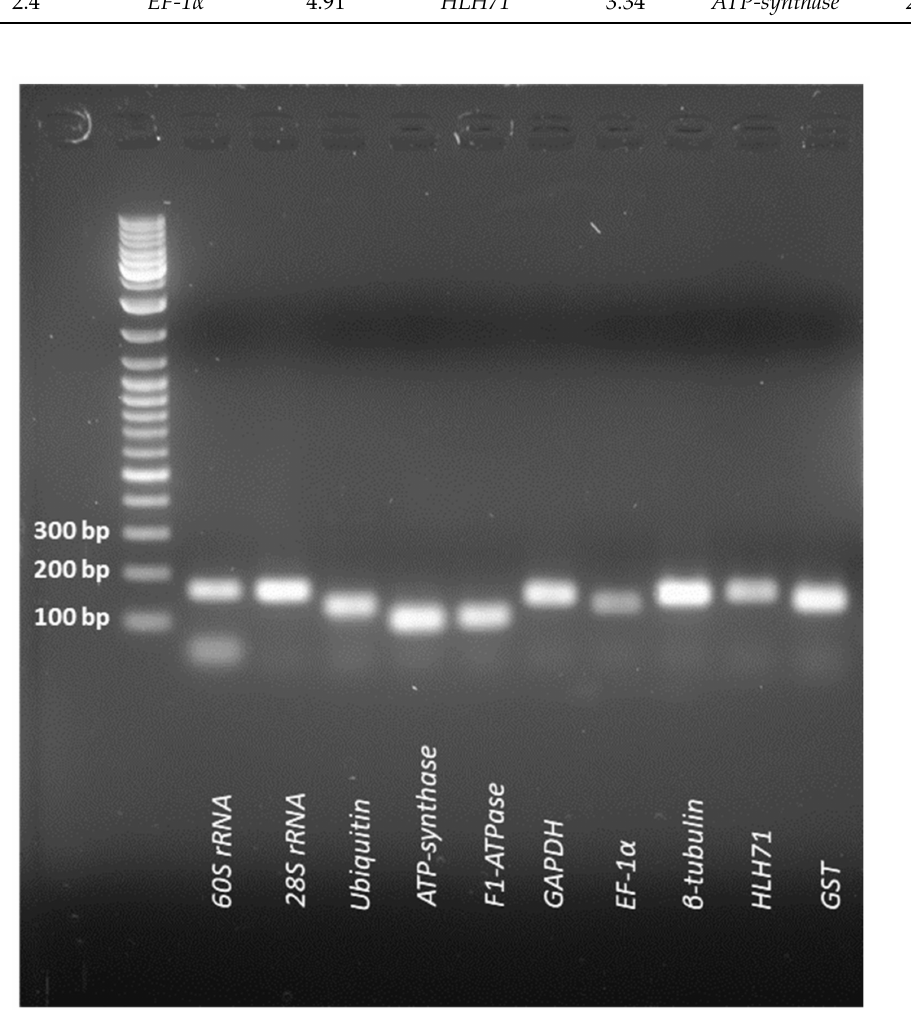
Figure 2. Candidate reference genes on 1.8% agarose gel with single bands for